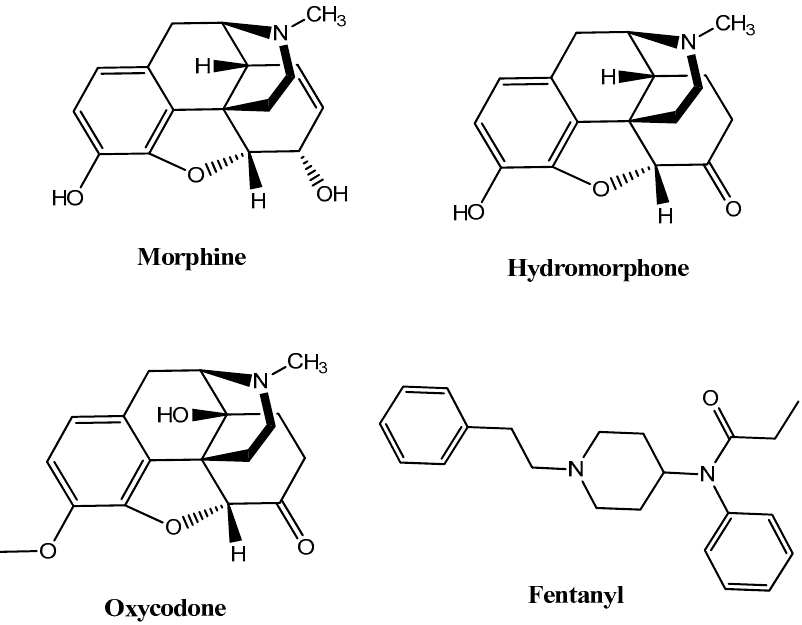
Figure 1. Most of the representative µ-opioid receptor (MOR) agonists reported so far.